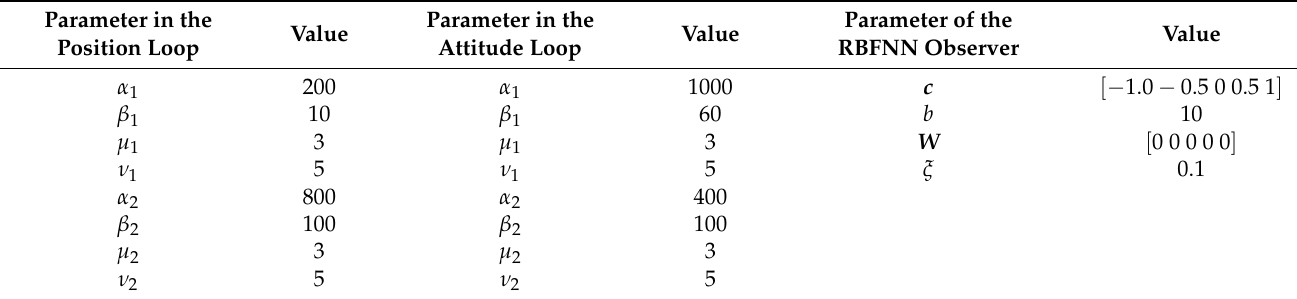
Table 2. Parameters of NGFTSMC based on RBFNN